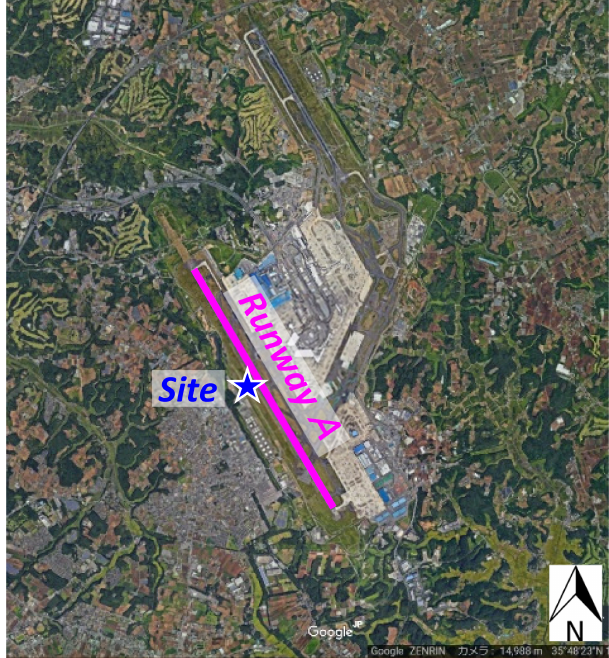
Figure 1. Map of the measurement